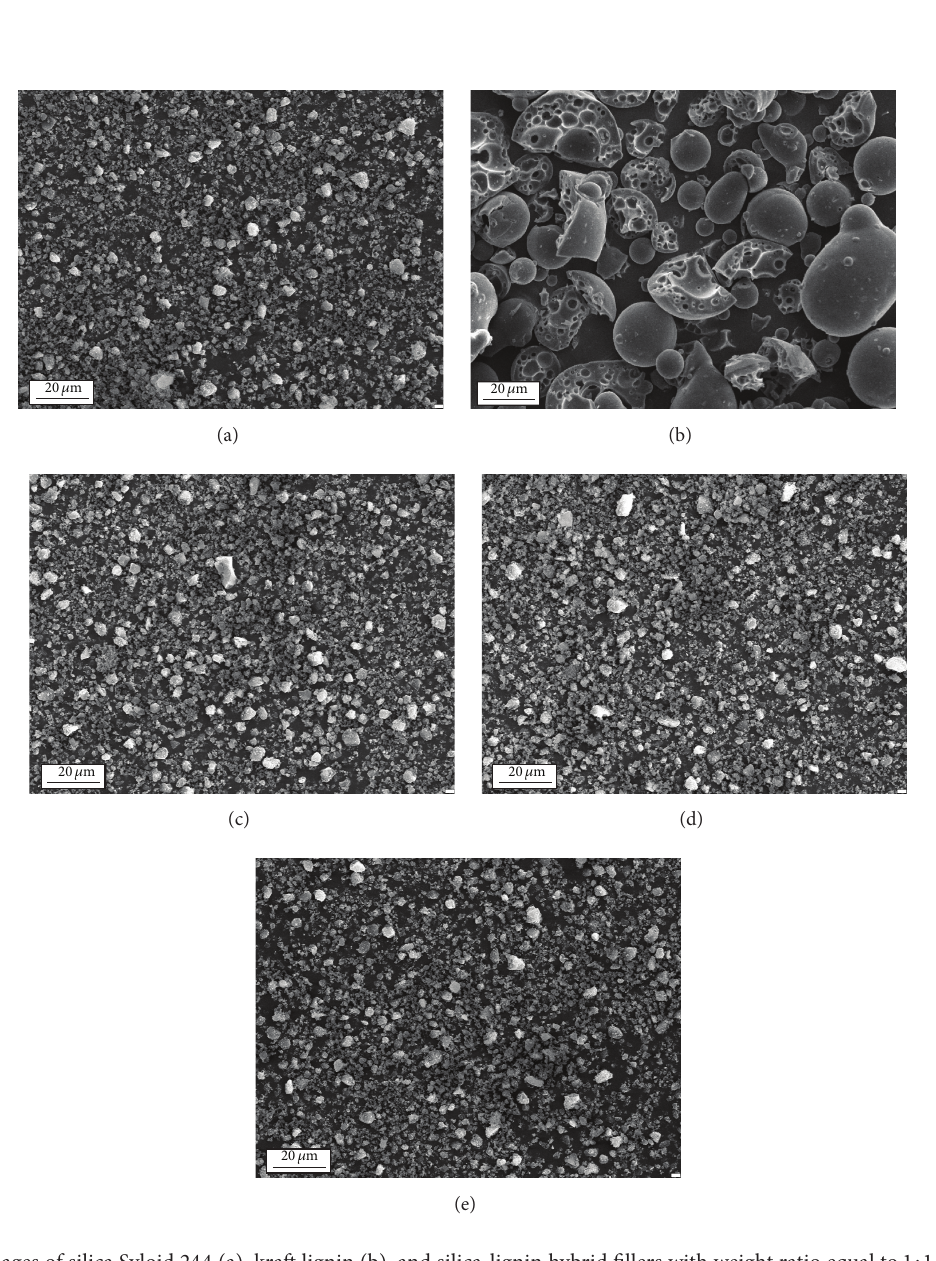
Figure 2: SEM images of silica Syloid 244 (a), kraft lignin (b), and silica-lignin hybrid fillers with weight ratio equal to 1: 1 (c), 2 :1 (d), and 5:1